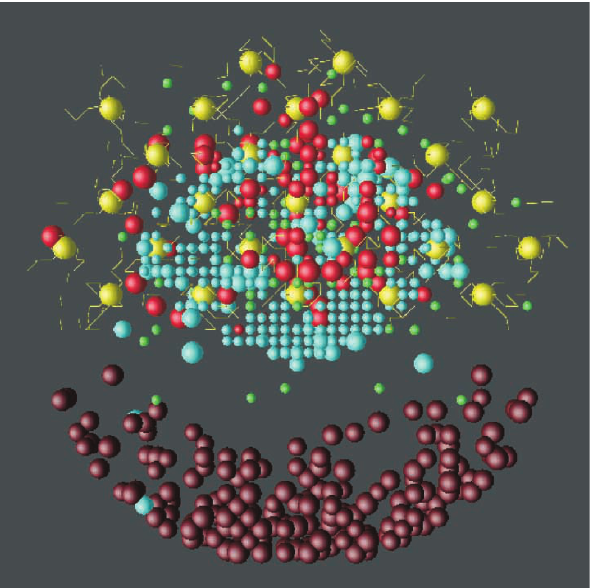
FIGURE 6 A gap between dark and light zone: a GC simulation (day 8) using the chemotaxis model, with a FDC-derived chemotactic signal acting on centrocytes, and with a centroblast differentiation signal diffusing on the GC volume. In this scenario, an unphysiological gap develops between dark and light zones. Centroblasts (dark red), recycled centroblasts (light red), centrocytes (cyan), output cells (green), FDCs